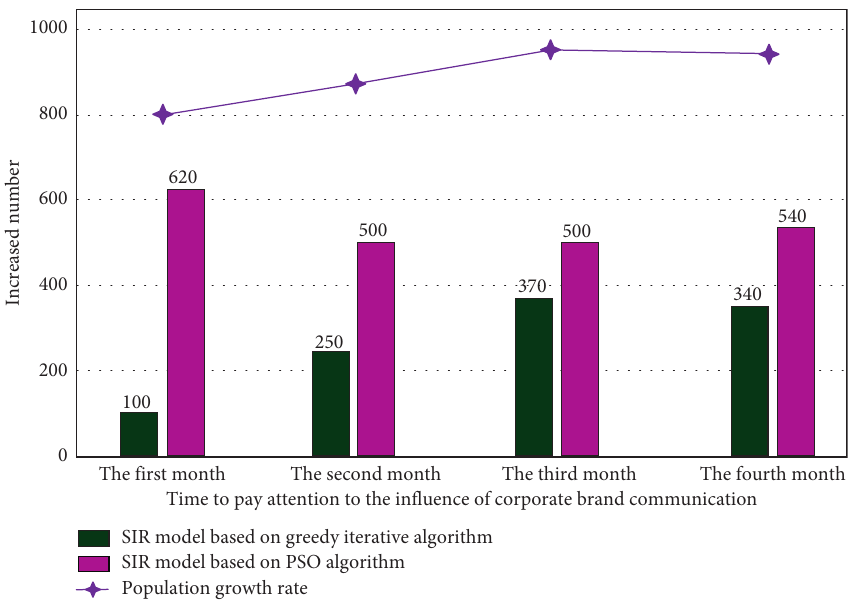
Figure 9: A comparison of the increase in the number of people who pay attention to the influence of corporate brand communication over